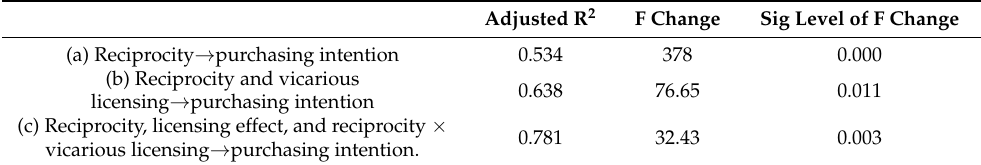
Table 10. The results of moderating effect of vicarious licensing on purchasing